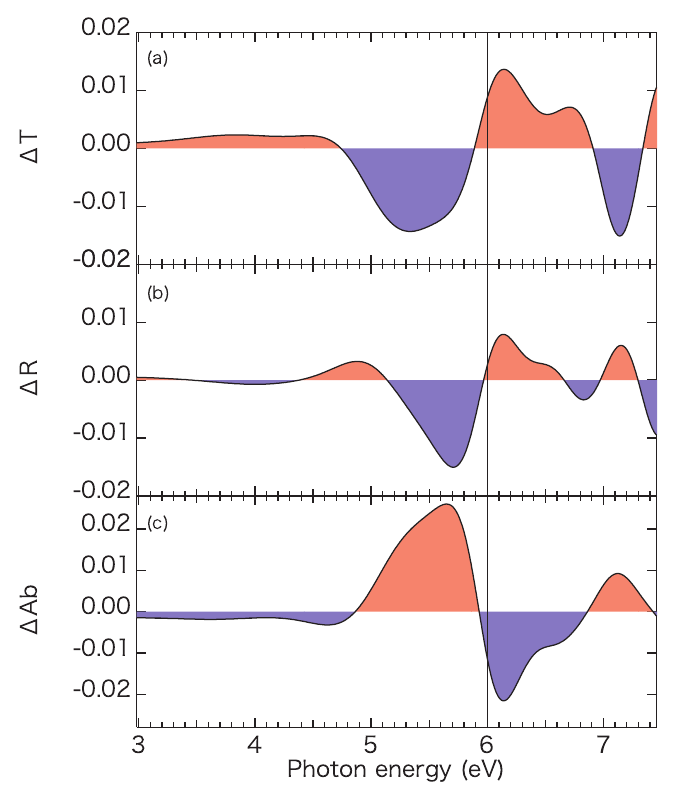
Figure 2. Change of the ( a ) transmission, ( b ) reflectivity, and ( c ) absorption of the probe pulse. Positive value (negative value) filled by red (blue). The vertical solid line presents the optical band